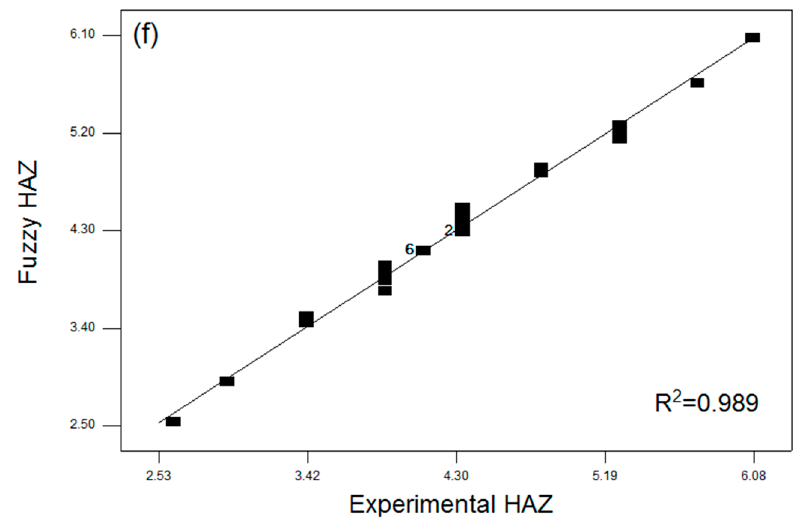
Figure 9. (a–f). Comparison of regression and fuzzy models with experiments on MRR, KT, and HAZ.